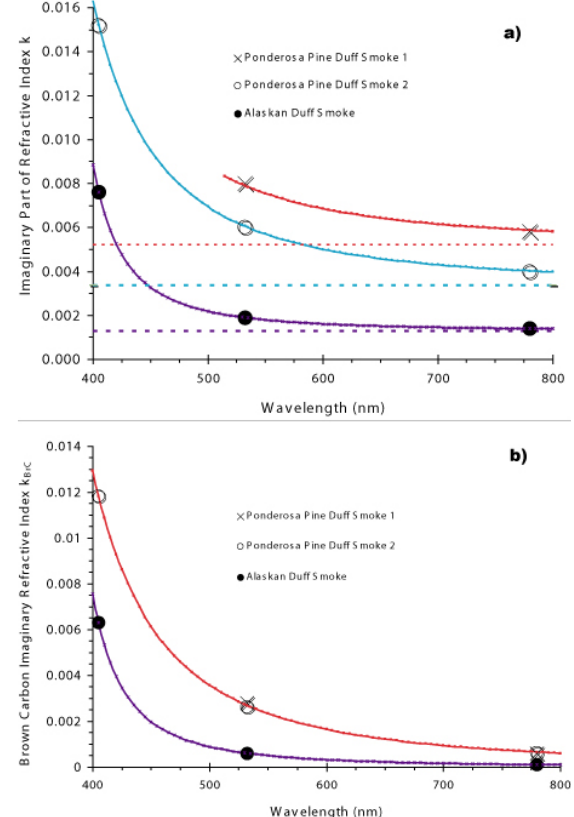
Fig. 4. (a) Data (individual points) and models (solid lines) of the Figure 4 imaginary part of the refractive index k of the volume averaged con- tributions of black carbon (BC) and brown carbon (BrC) as func- tion of wavelength for Ponderosa Pine Smoke 1 and 2 and Alaskan Duff Smoke. The wavelength independent components k BC of k are shown as dotted lines for the three individual smoke samples. (b) Data (individual points) and models (solid lines) of the imag- inary part of the refractive index k as function of wavelength for the brown carbon component of Ponderosa Pine Smoke 1 and 2 and Alaskan Duff Smoke. The fact that the data points for Ponderosa Pine Smoke 1 and 2 are nearly identical indicates that differences in the imaginary parts of their refractive indices are predominantly due to different black carbon